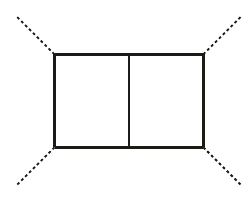
Figure 6 . Seven-line double box